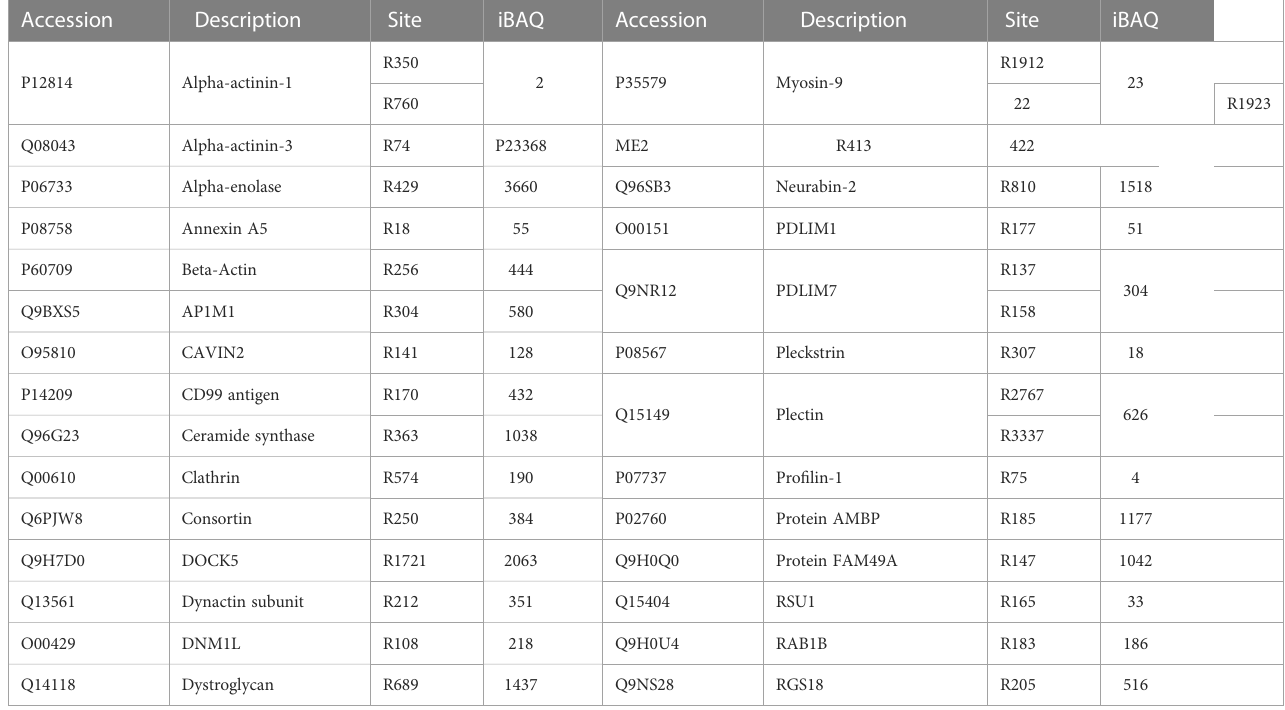
TABLE 1 Citrullination modi fi cations present in human